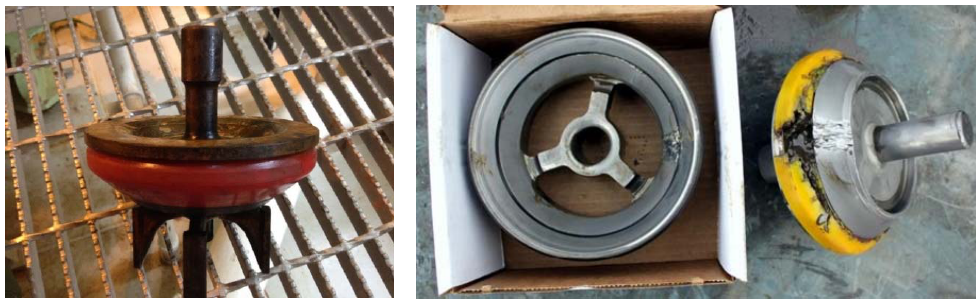
Figure 6. Offshore rig day rates [8,9]. The authors propose to use the propagation of acoustic emission elastic waves, or more specifically, the generation of certain characteristic frequencies associated with a particular kind of machine fault. In a classical case, in terms of physics, acoustic emission is a phenomenon of spontaneous generation of elastic waves by regrouping the internal structure of solids (seldom liquids) and physical systems. Elastic waves are also excited by sources affected by a physical process, such as flow of a medium, friction or local, dynamic change in the structure of the material (e.g., hitting of a valve head). Failures related with mud pumps, or more precisely with leaking valves in the fluid end, might often be avoided through the implementation of the proper maintenance strategy [6]. If a valve (see Figure 7) works more than 500 h at 100 cycles per minute, the spring will be